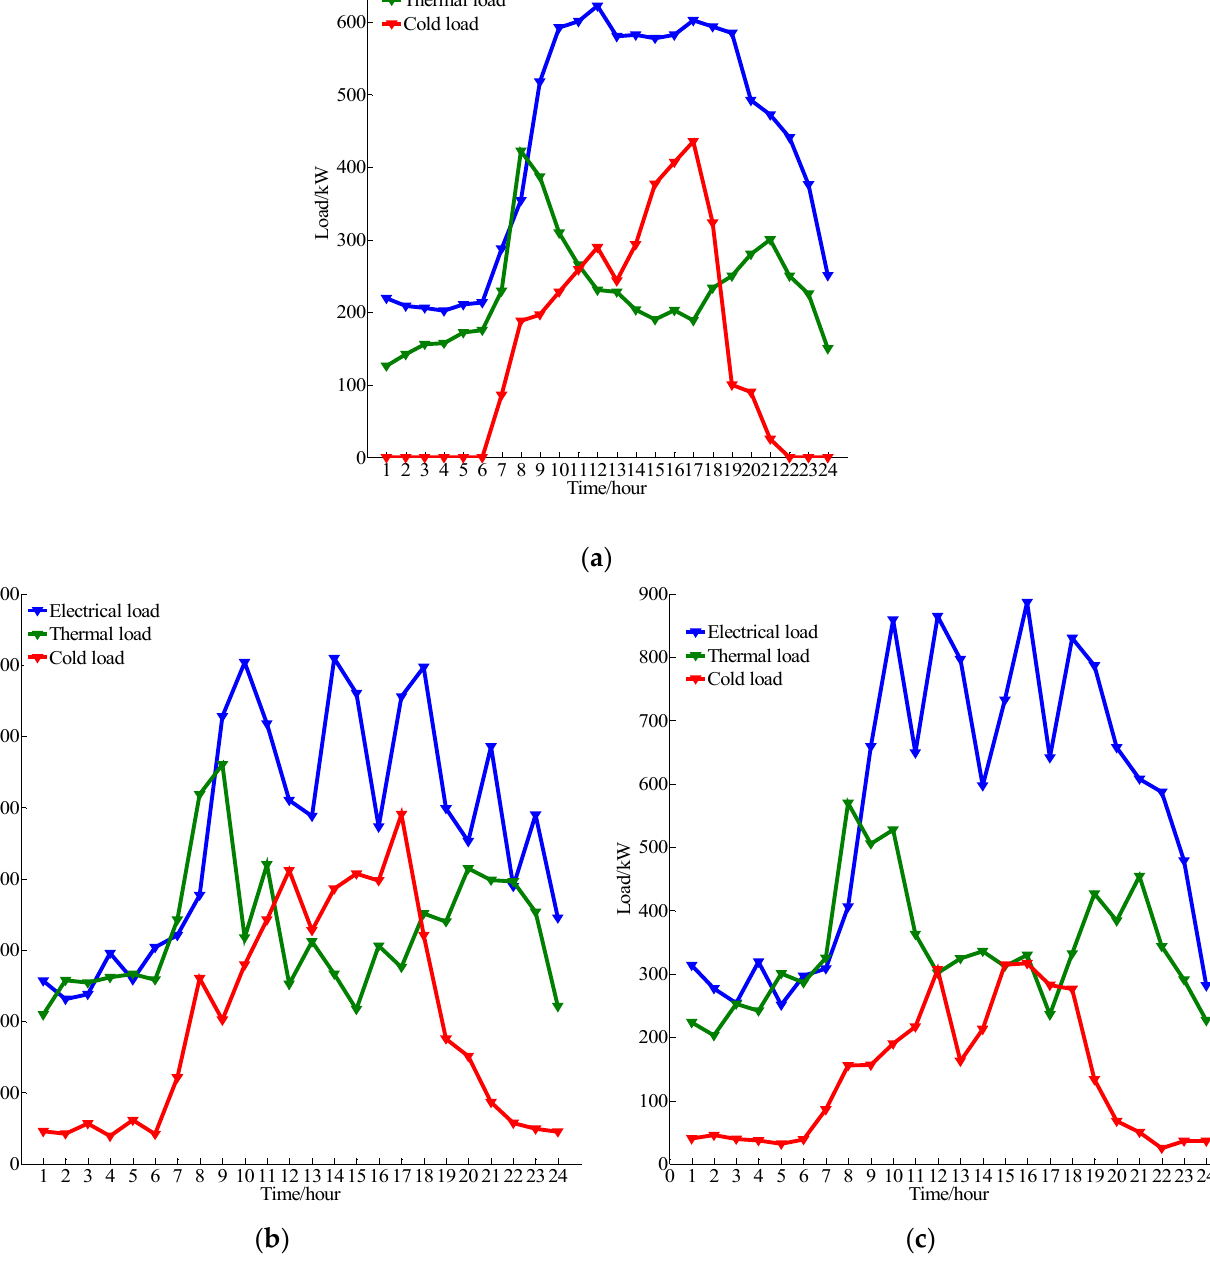
Figure A1. Electrical load, heat load, and cold load: ( a ) MES 1; ( b ) MES 2; ( c ) MES 3. The PV and wind power output of each subsystem is shown in Figure A2.